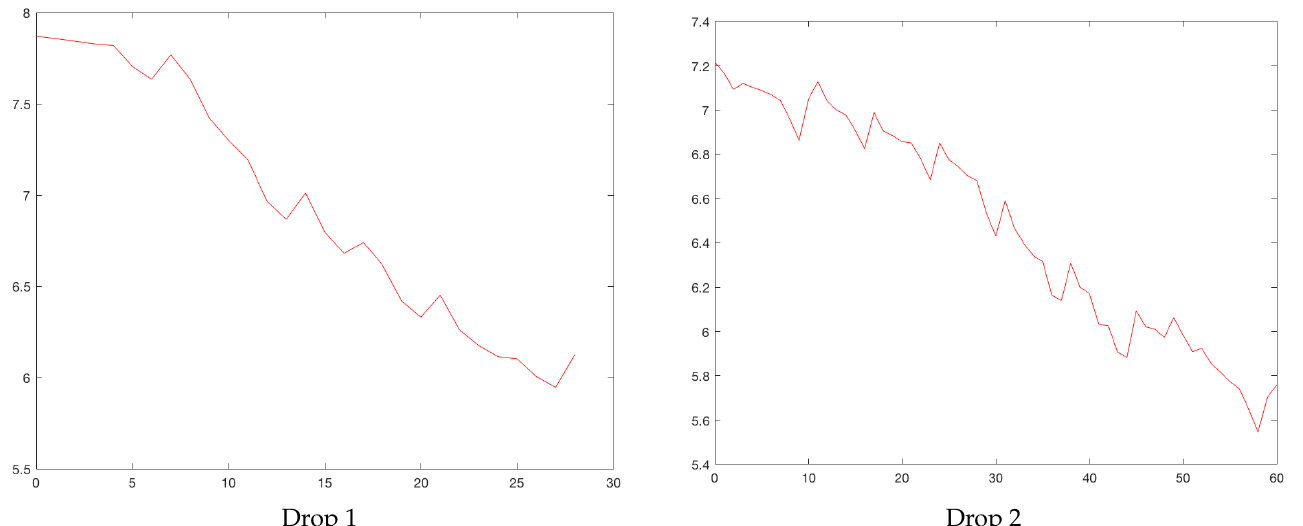
Figure A11. Lyon’s drops. Horizontal axis, days; vertical axis: logarithm of daily cases.